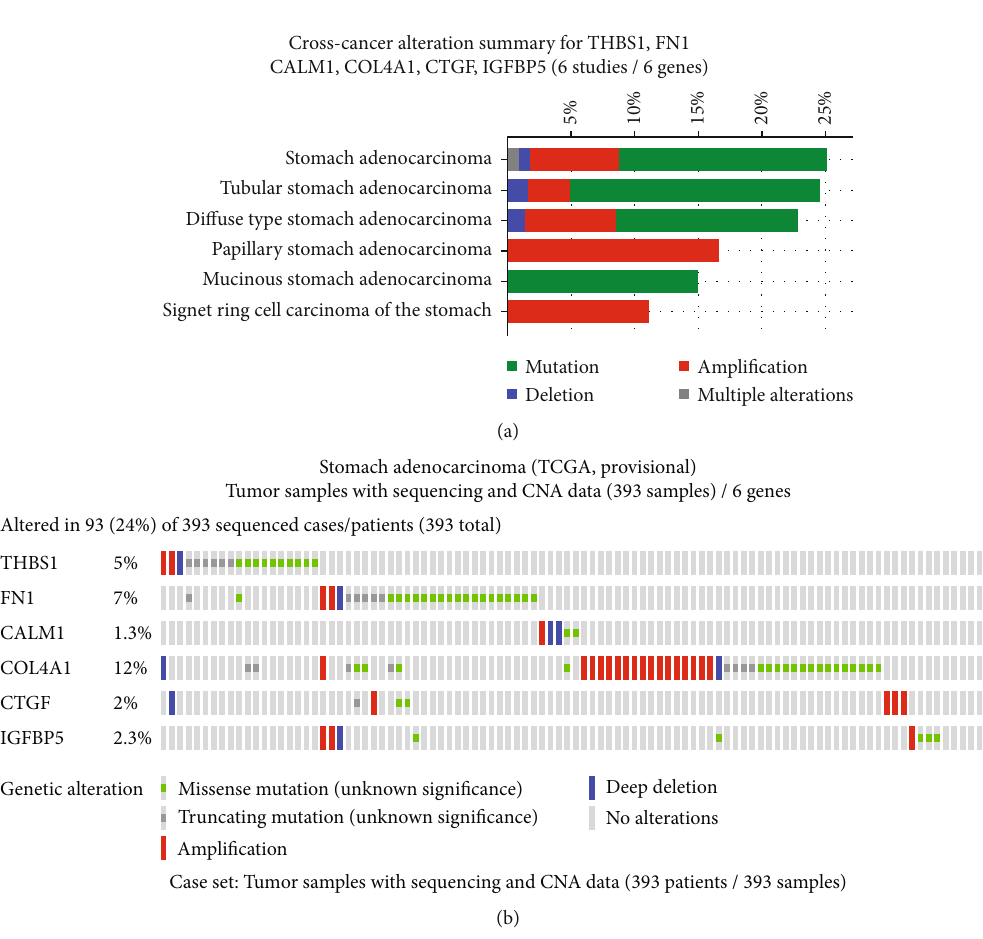
Figure 6: Exploring genetic alterations in THBS1, FN1, CALM1, COL4A1, CTGF, and IGFBP5 in GC by cBioPortal: (a) summary of changes within THBS1, FN1, CALM1, COL4A1, CTGF, and IGFBP5 genes in genomics datasets available for stomach adenocarcinoma (TCGA, Provisional) studies; (b) OncoPrint: a visual summary of alterations across a set of stomach adenocarcinoma samples (data are taken from TCGA Data Portal) based on a query of the 6 genes (THBS1, FN1, CALM1, COL4A1, CTGF, and IGFBP5). Distinct genomic alterations are summarized, color-coded, and presented as percent changes in particularly a ff ected genes in individual tumor samples. Each row represents a gene, and each column represents a tumor sample. Green squares indicate missense mutations; black represents truncating mutations; red bars designate gene ampli fi cations; blue bars represent deep deletions, and grey signi fi es no